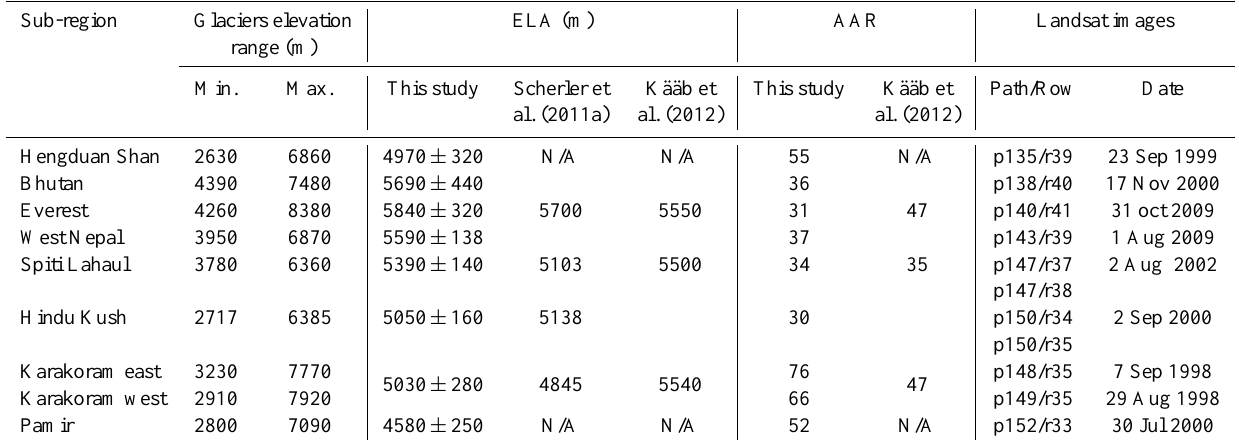
Table 2. Elevation ranges, equilibrium line altitudes (ELA) and accumulation area ratios (AAR) for the nine study sites. The dates of acquisition of Landsat images used for ELA determination are also given. Sub-region Glaciers elevation ELA (m) AAR Landsat images range (m) Min. Max. This study Scherler et Kääb et This study Kääb et Path/Row Date al.